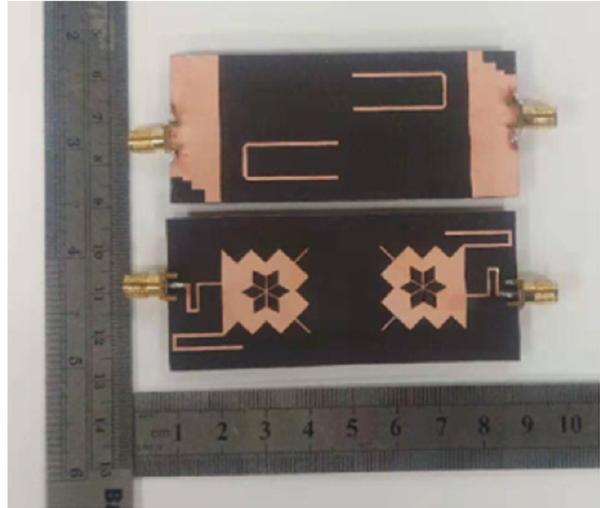
Figure 7. Fabricated prototype of the structure [23].